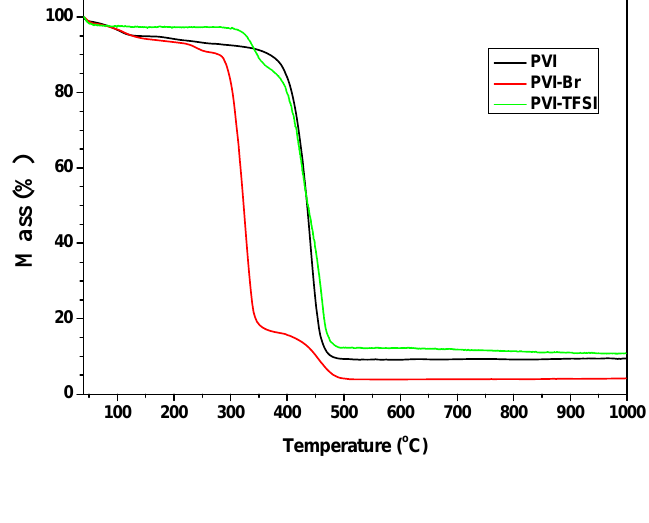
Figure 4. TGA curves of PVI, PVI-Br and PVI-TFSI scanning from 40 to 1000 °C at a heating rate of 10 K/min under argon